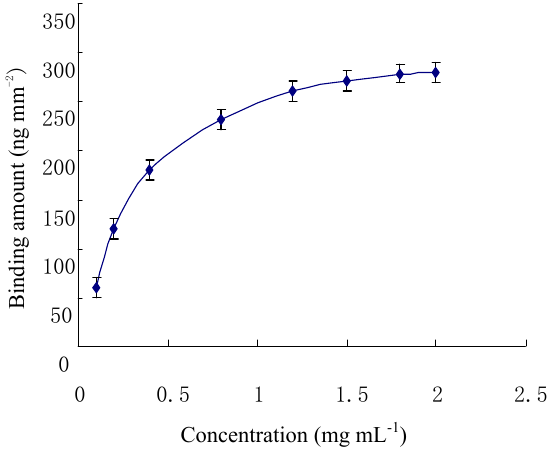
Figure 4. Optimization of ET-1 concentration to immobilize on the QCM substrate(pH 7.4